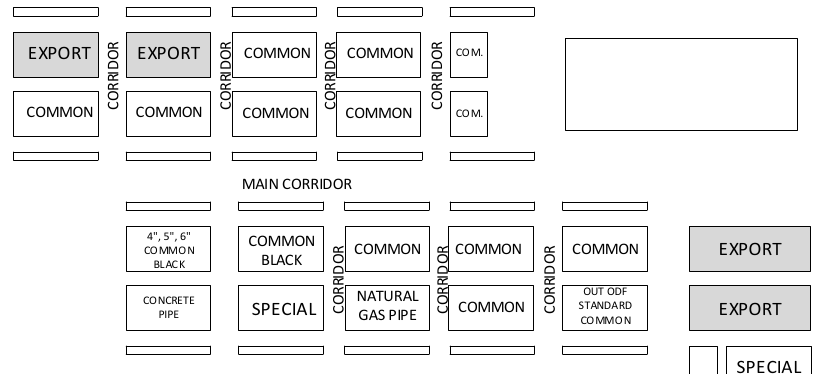
Figure 9. New storage area layout.